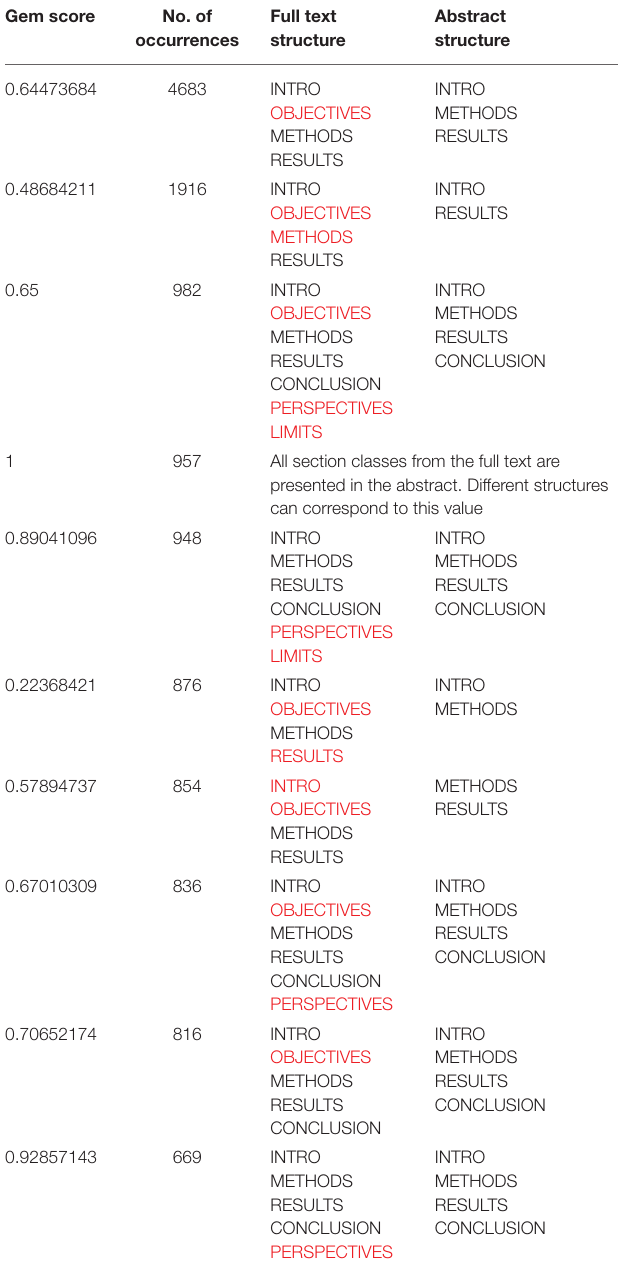
TABLE 3 | Numbers and typology of abstracts according to the structure of the full text (sections missing from the abstract appear in